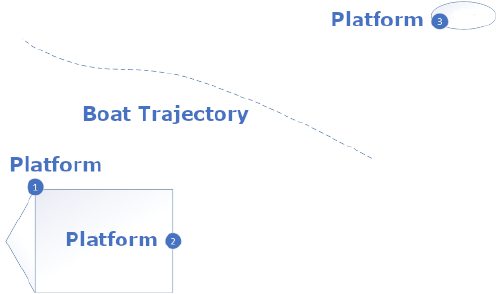
Figure 10. Schematic of the boat tracking experiment.